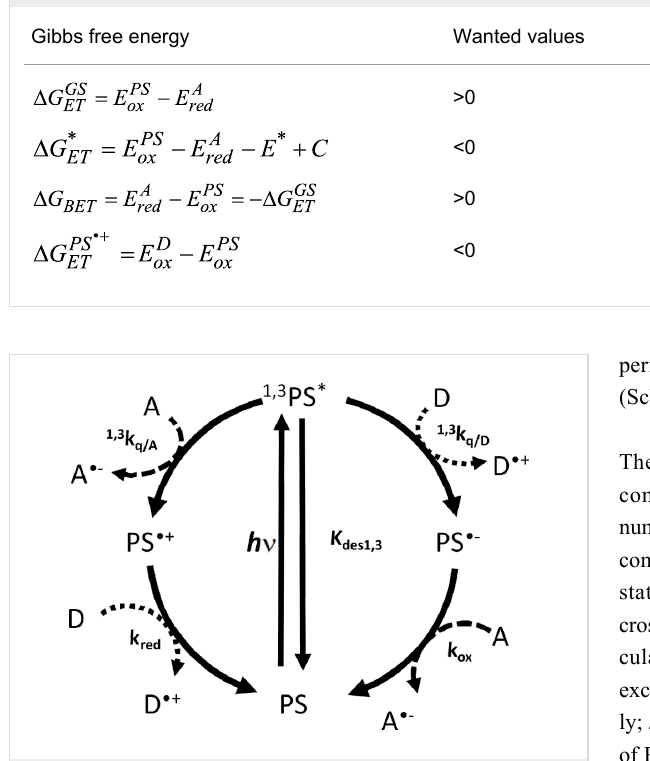
Scheme 5: General photocatalytic cycle occurring in three compo- nents photocyclic systems. Two cycles are in competition: on the right side the first reaction occurs with the donor D defining the reductive pathway, while on the left side the primary reaction occurs with the acceptor A leading to the oxidative